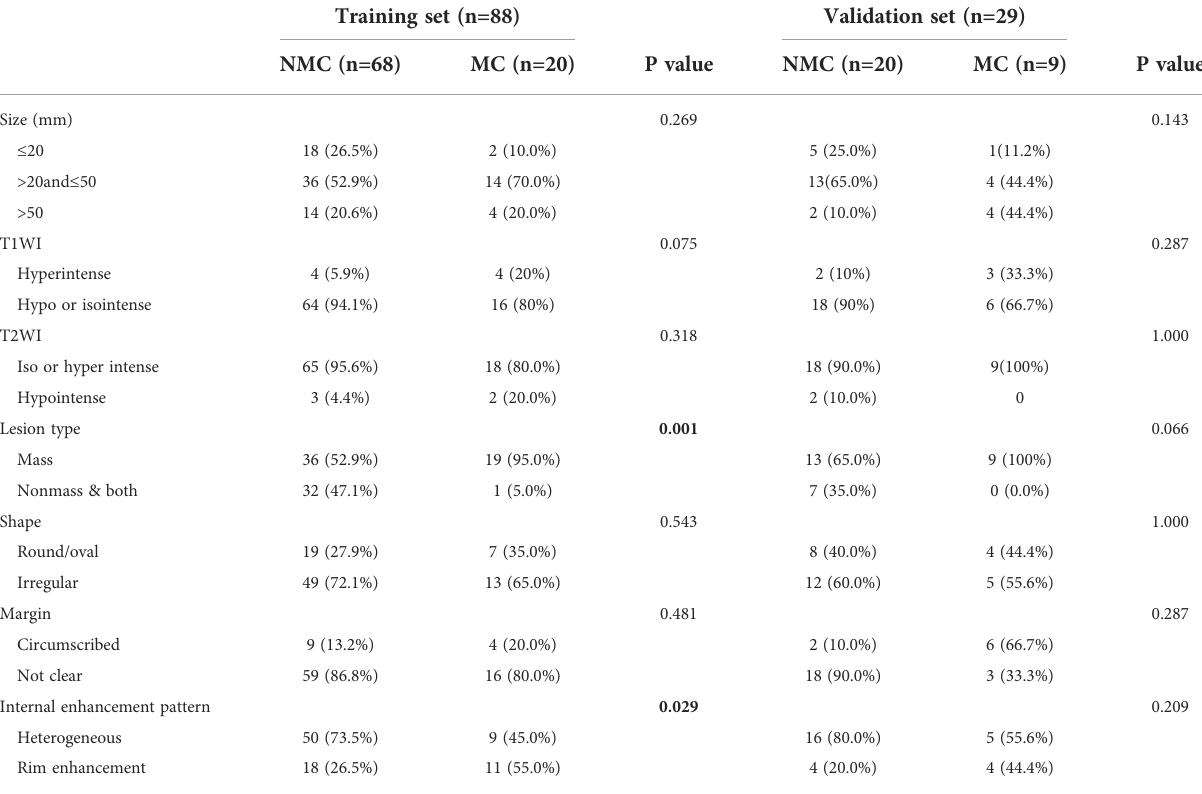
TABLE 3 MRI features of TNBC-MC and TNBC-NMC in the training and validation